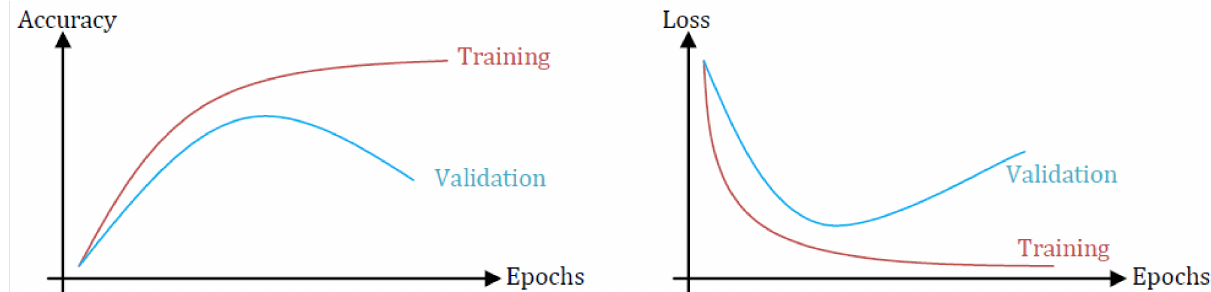
Figure 11. Accuracy and loss versus the epochs